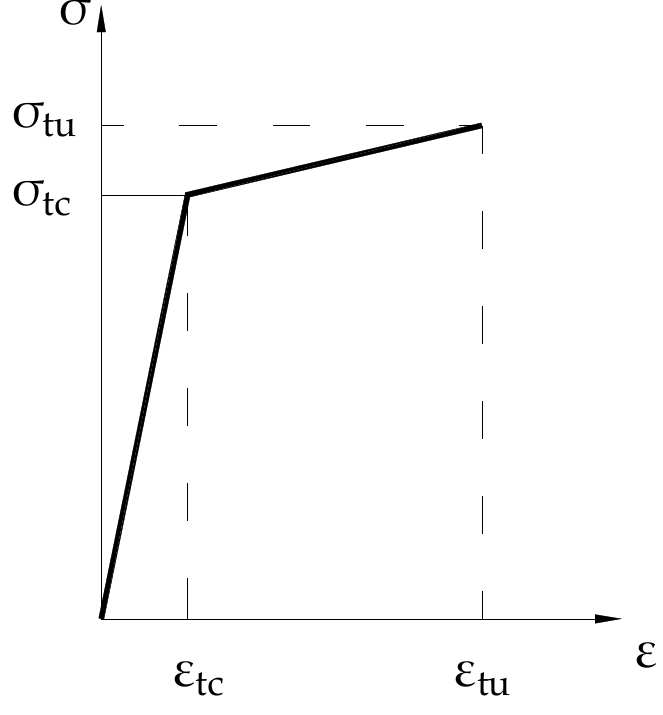
Figure 18. ECC tensile stress–strain curve.